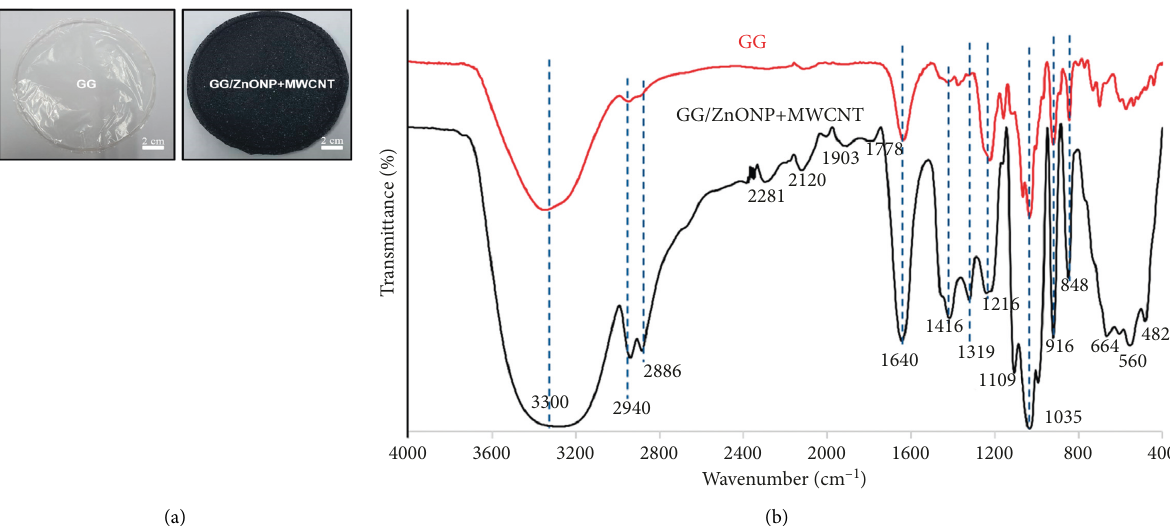
Figure 1: (a) The photo images and (b) FTIR spectra of pure GG film and GG/ZnONP+ MWCNT bionanocomposite film.